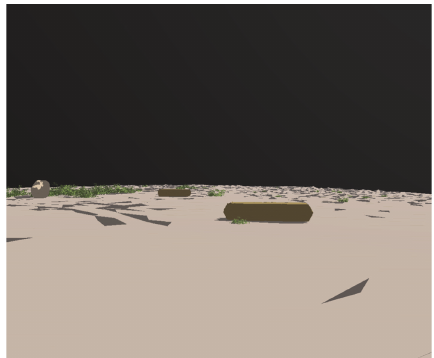
Figure 3: Sceen capture of the simulated scene mesh corresponding to part of the area shown in Figure 1.